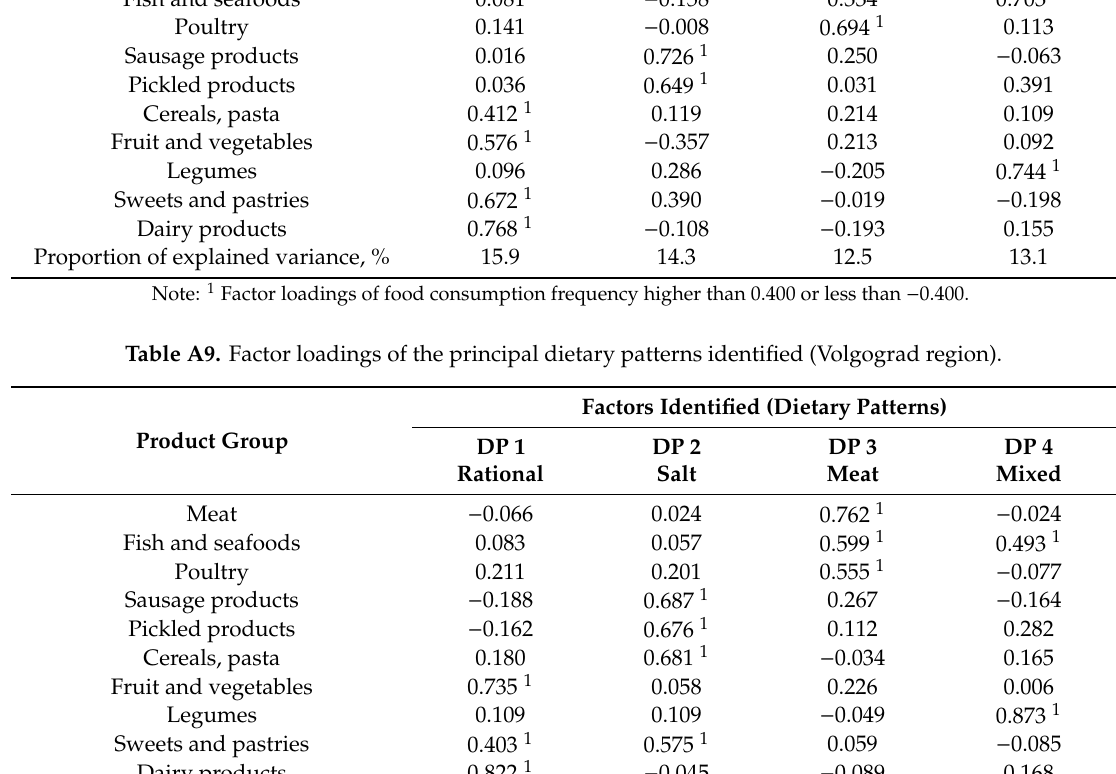
Table A8. Factor loadings of the principal dietary patterns identified (Primorsk Territory).